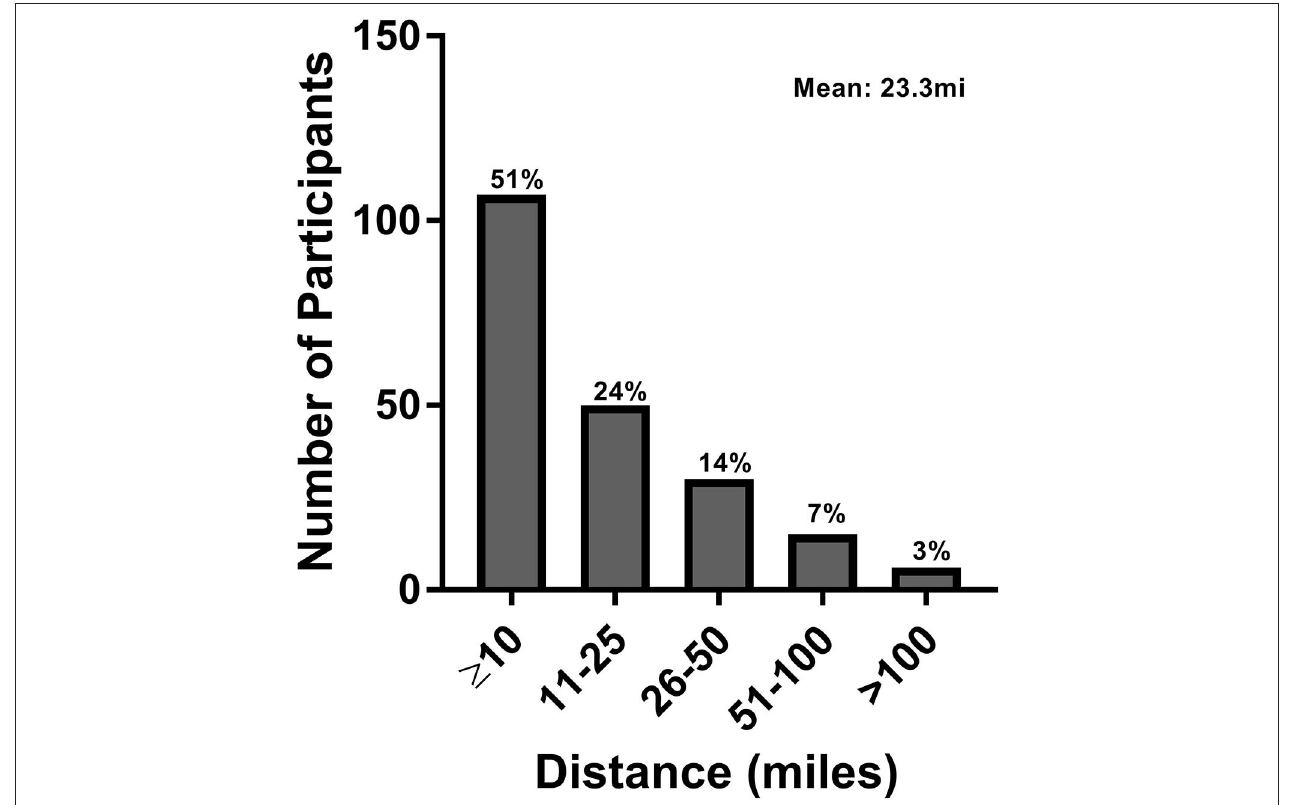
FIGURE 1 | Patient distance between home and